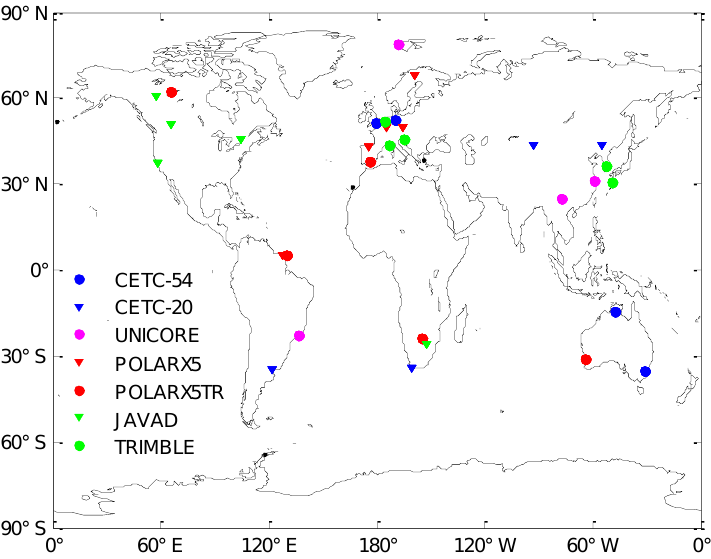
Figure 2. Distribution of iGMAS and MGEX stations used for analysis. Table 2. Information of receivers.